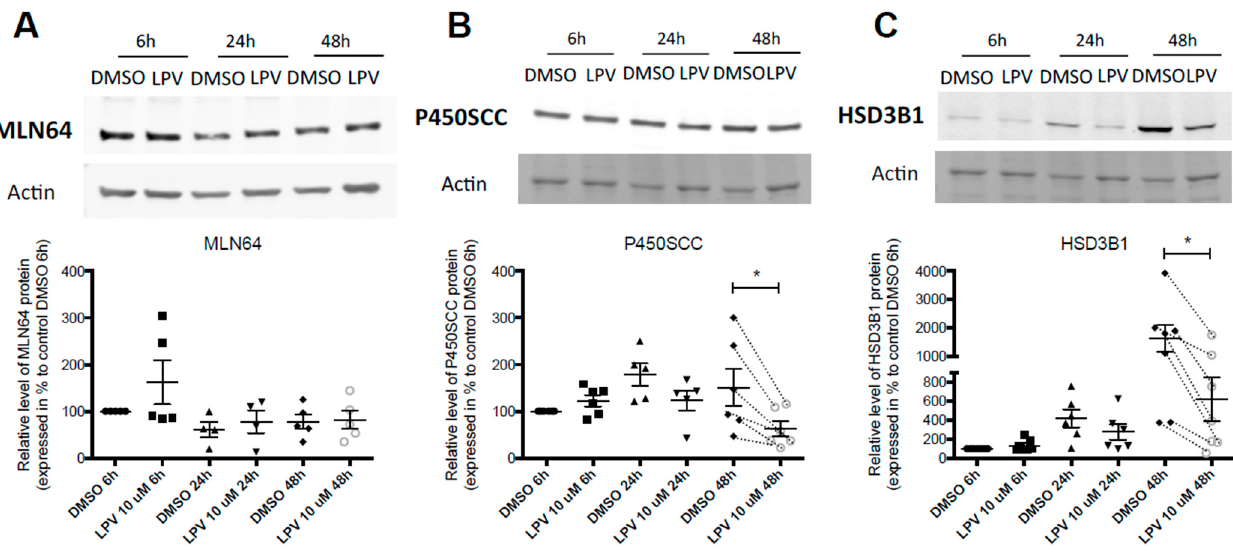
Figure 4. Lopinavir decreases protein expression of enzymes P450SCC and HSD3B1 involved in progesterone synthesis during differentiation of VCT into ST. Human VCT isolated and purified from term placenta were cultured for 15 h and then incubated with LPV 10 µM or DMSO for 6 h, 24 h or 48 h. MLN64 ( A ), P450SCC ( B ) and HSD3B1 ( C ) protein expression was determined using immunoblotting with anti-MLN64, anti-P450SCC and anti-HSD3B1 antibodies. Actin protein was determined with anti-actin antibody, used as a loading control. The lanes intensity was measured with ImageJ program. Results are expressed as a percentage of the control DMSO 6 h conditions and are shown as mean − /+ SEM from six independent experiments. * p < 0.05 vs. DMSO at the same incubation time, two-tailed paired no parametric paired t -test.